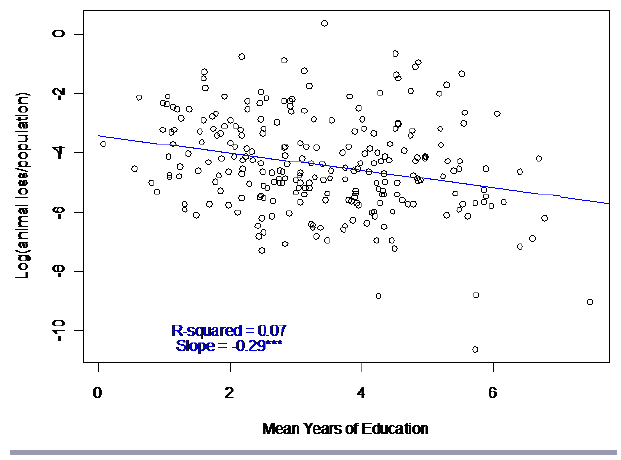
Fig. 6 . Log of the ratio of number of animals lost and size of the population and the mean years of schooling of the population aged 15-39